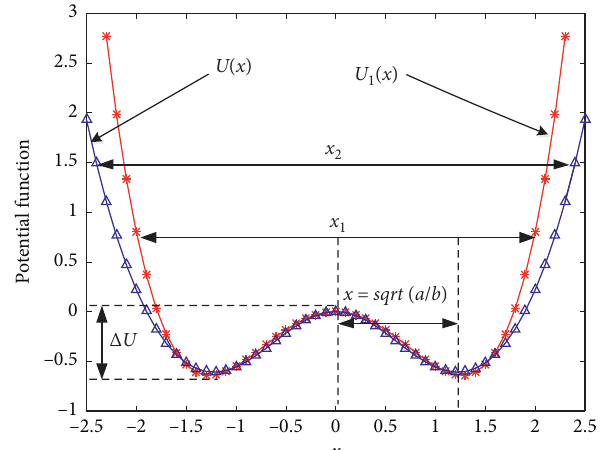
Figure 1: The mixed potential function model curve U ( x ) and the CBSR potential function curve U